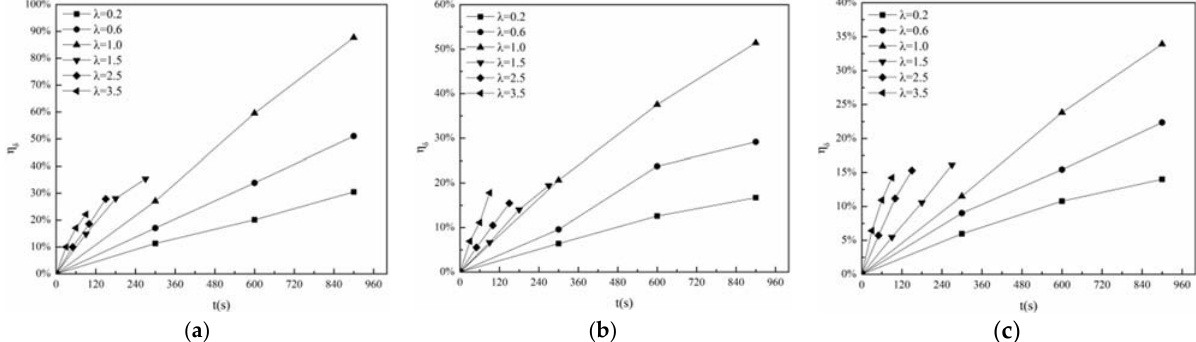
Figure 12. Variations of the dimensionless stagnation point thickness with the icing time: ( a ) d = 20 mm; ( b ) d = 30 mm; ( c ) d = 40